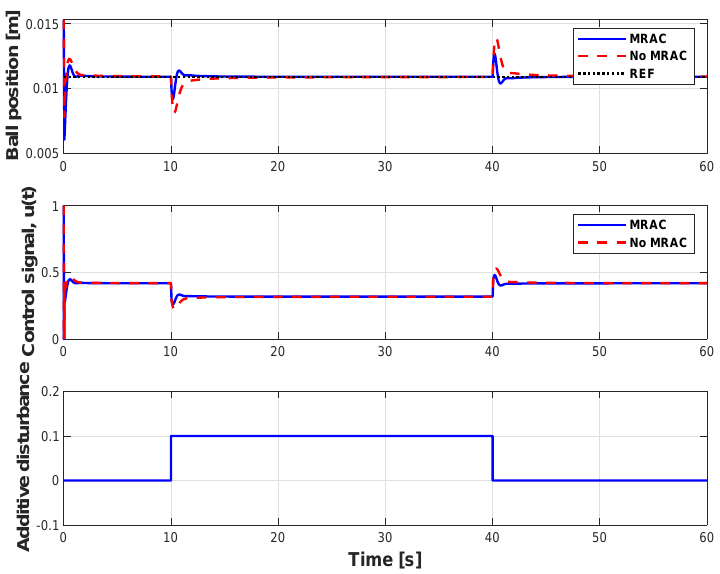
Figure 12. Disturbance responses of the multi-loop MRAC-FOPID control with NARX reference model and the FOPID control loop (When MRAC is disabled).